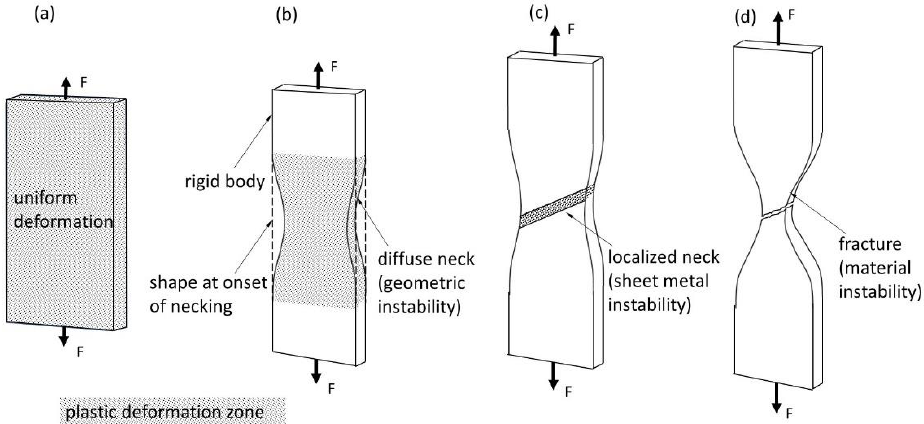
Figure 1. Tensile test phases in a flat specimen: ( a ) uniform deformation, ( b ) geometric instability, ( c ) localised necking, ( d ) cracking. ( c ) localised necking, ( d )